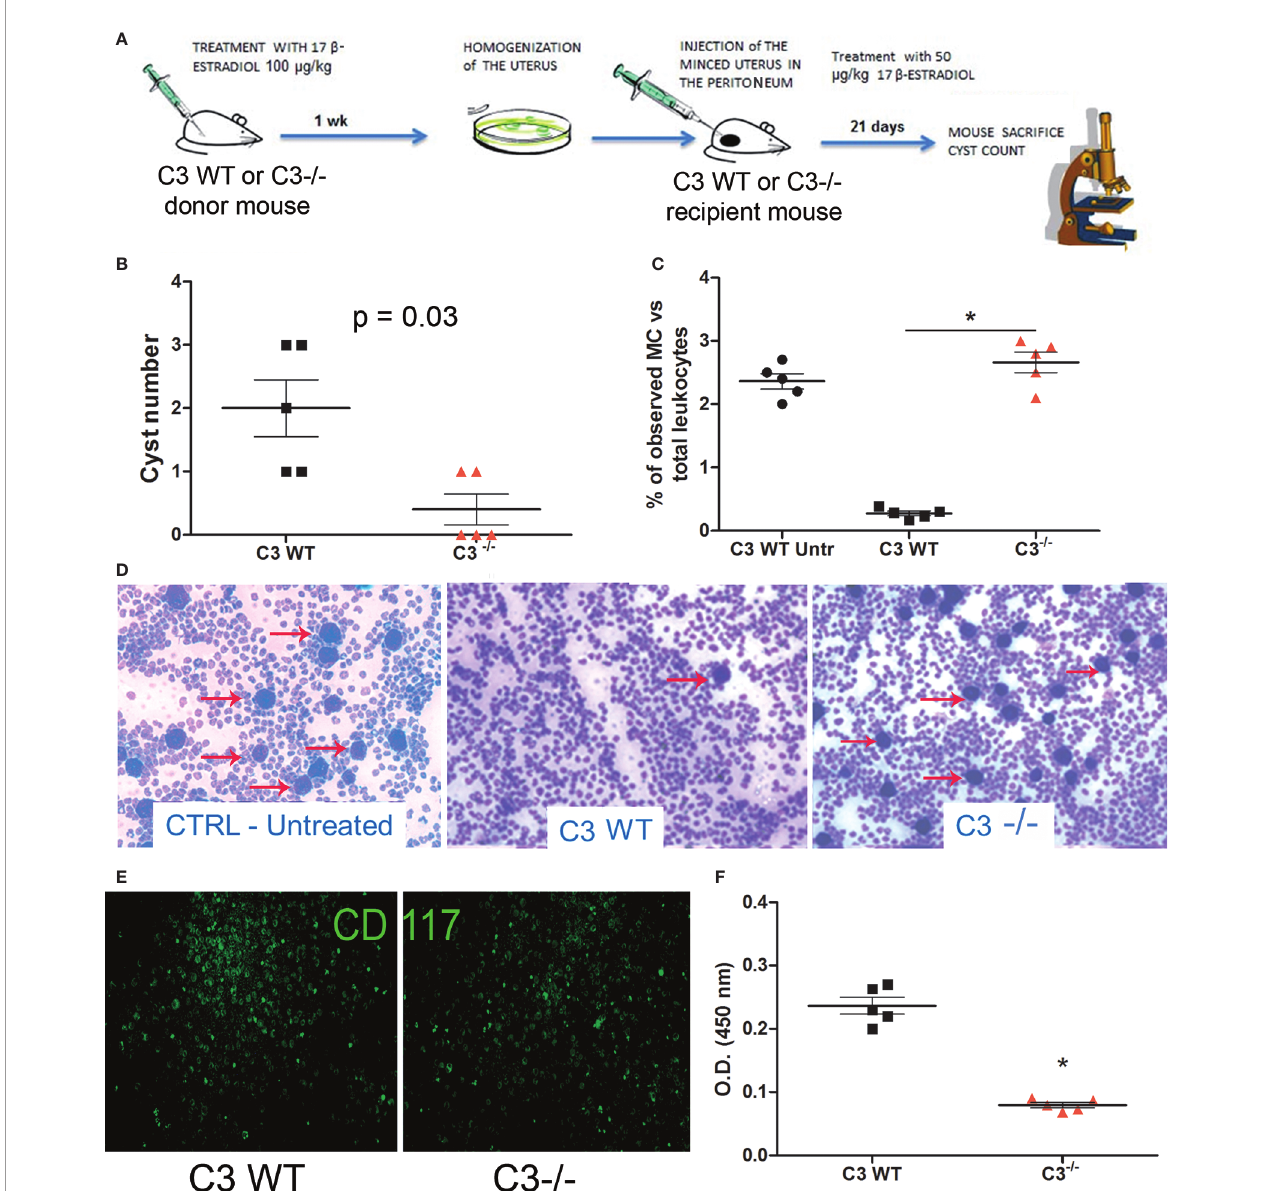
FIGURE 2 | In vivo syngeneic mouse model of EM. (A) Treatment regimen of C3 WT and gene-de fi cient mice for generating EM in vivo model. Five C3 -/- and WT mice each were injected (i.p.) with minced uterus of a donor mouse C3 -/- and WT respectively; after 3 weeks, the peritoneal cyst formation was evaluated. (B) Number of cysts counted in wild-type (WT) mice injected with WT endometrium ( n = 5) or C3 -/- injected with C3 -/- endometrium ( n = 5). Mann-Whitney test p = 0.03. (C, D) Representative images of cytocentrifuged peritoneal washing of untreated WT, EM-induced WT and C3 -/- mice (respectively), stained with Giemsa and counted with ImageJ software (Particle Analysis Tool) to obtain relative percentage between total leukocytes and mast cell (MC)/basophil number. MCs/basophils are identi fi ed as blue big dots indicated by red arrows. Original magni fi cation 100×. (E) Representative images of cytocentrifuged peritoneal lavage of EM-induced WT mice stained with FITC-conjugated anti-mouse CD117. Original magni fi cation 100×. (F) Biochemical characterization of tryptase enzyme present in peritoneal lavage of WT vs C3 -/- mice by ELISA. *p <